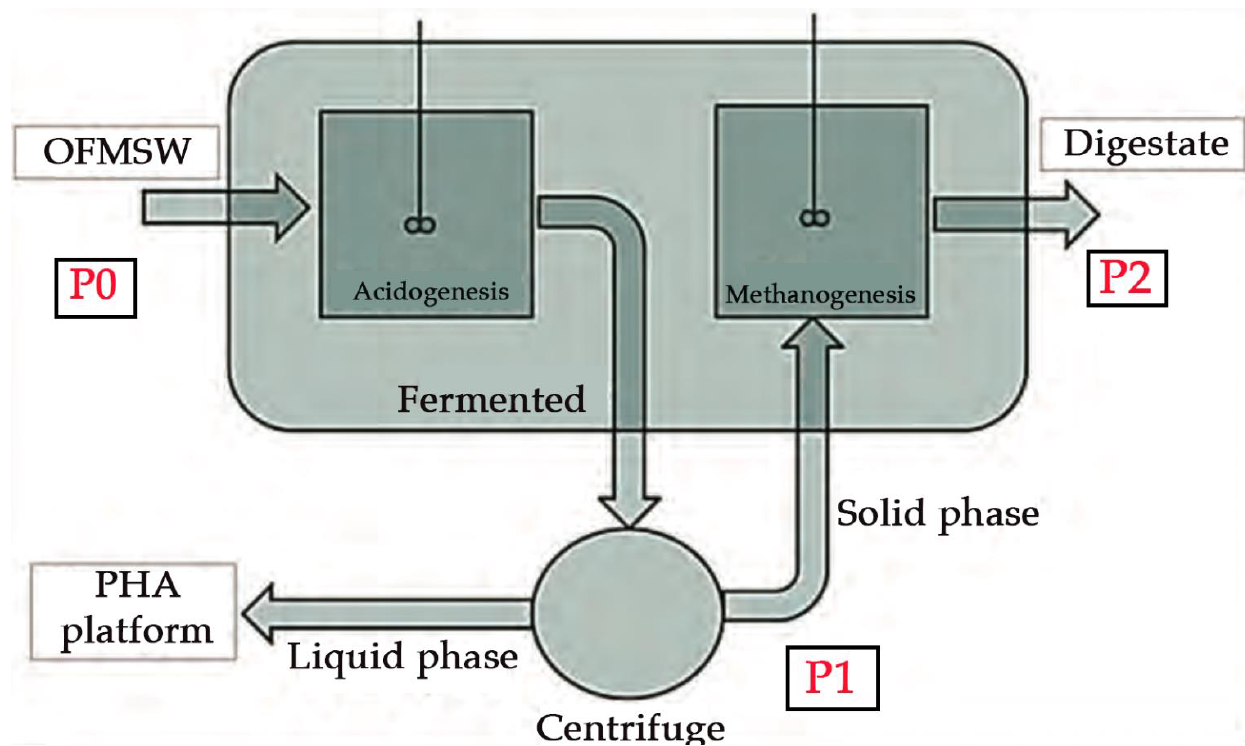
Figure 1. Three sampling locations (P0, P1, and P2) at the pilot plant. P0: Area dedicated to preparation of shredded organic fraction of municipal solid waste (OFMSW); P1: position next to entry point of OFMSW pre-treated by shredding or squeezing; P2: location of final methanogenesis.